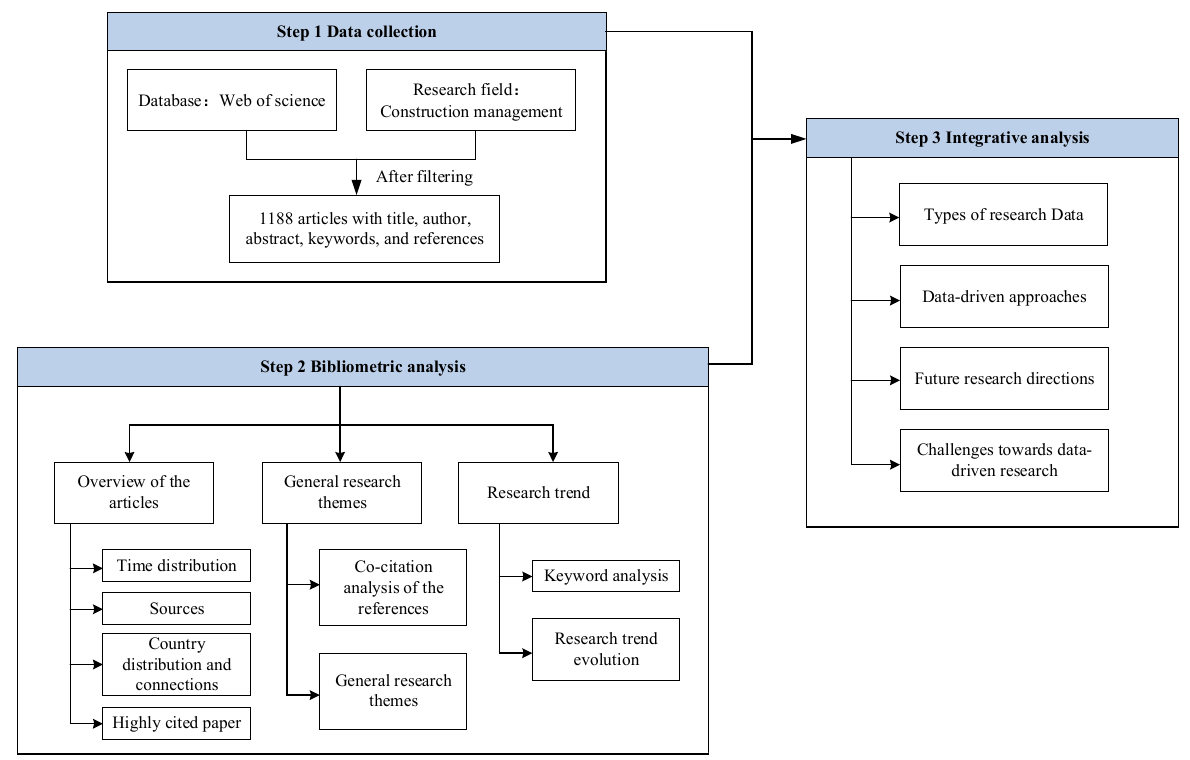
Figure 1. Flowchart of the methodology. Figure 1.